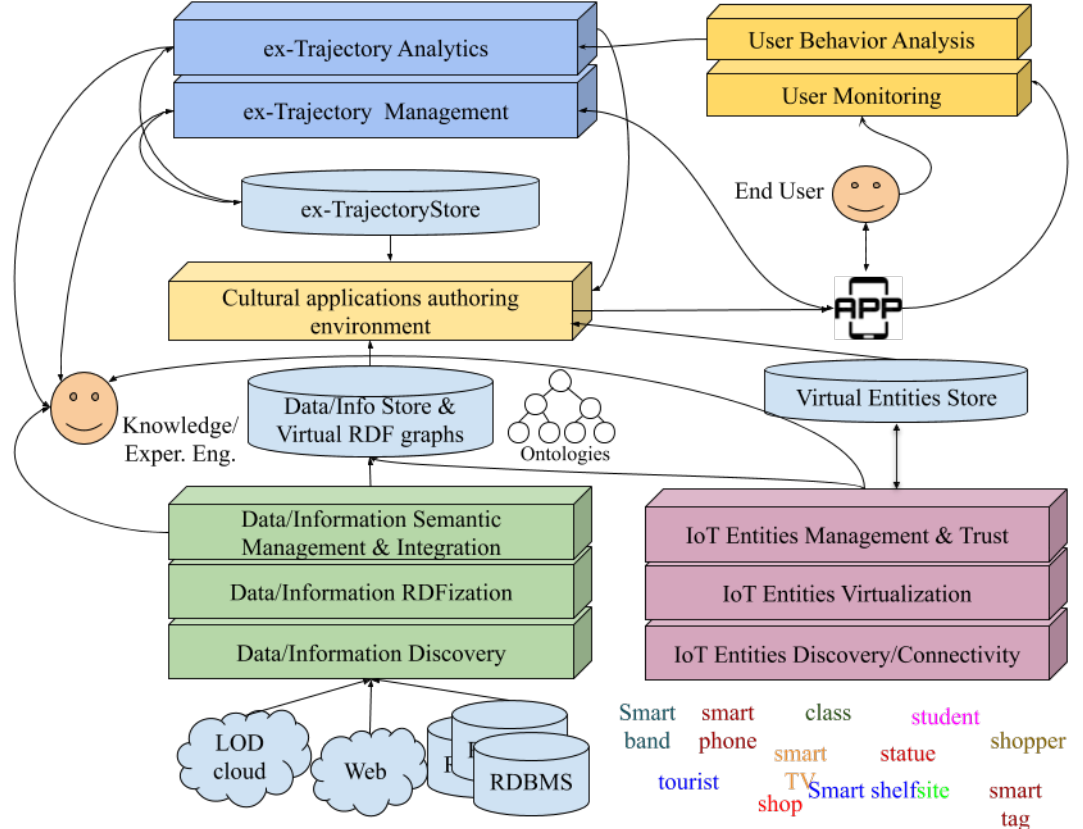
Figure 2. Proposed system design architecture based on SemMR framework.